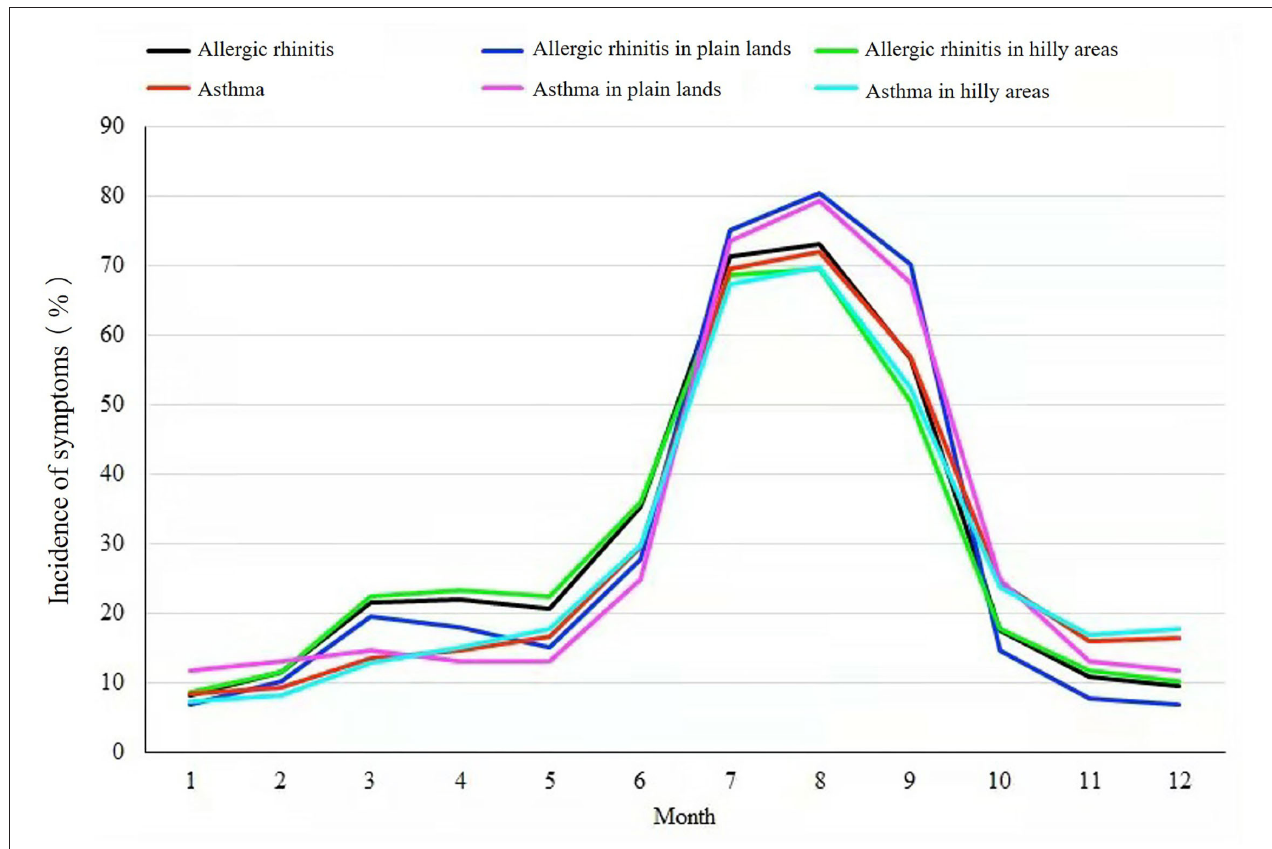
FIGURE 3 | Landform variation, seasonal variation, and incidence of symptoms of allergic rhinitis and